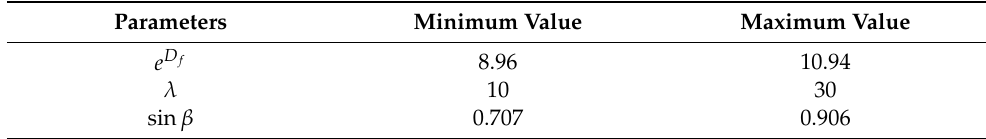
Table 4. The range of variation of the parameters used for training of the M5 tree.